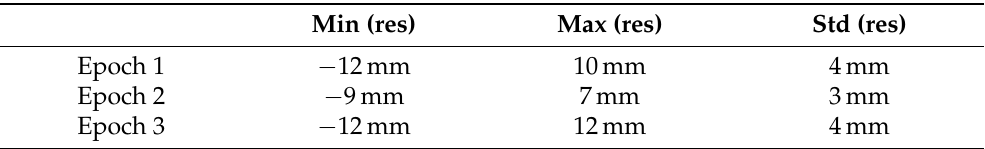
Figure 2. Accuracy assessment. Exemplary leaf of a plant (height: 18cm, width: 23cm) in three subsequent epochs and the 5cm × 5cm patch (cyan). Table 1. Statistical values (minimum, maximum and standard deviation) of the residuals (res) of the plane fitting sketched in Figure